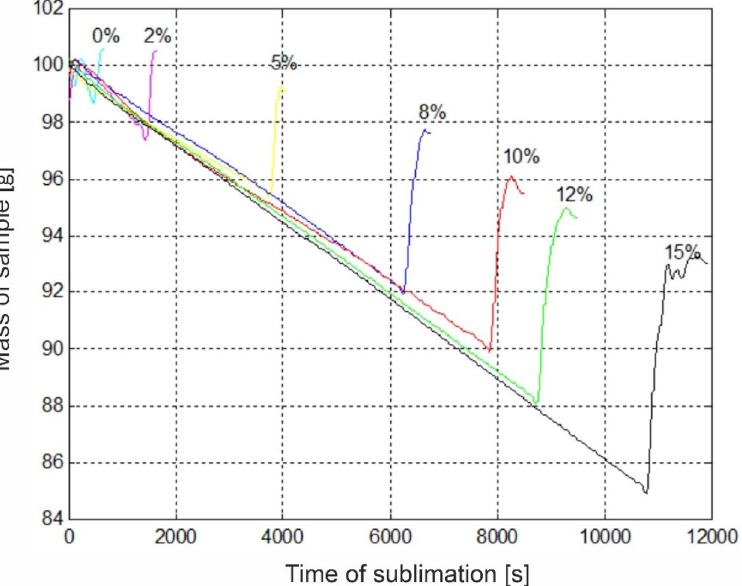
Figure 2. The mass of sample changes during sublimation for different degrees of sublimation dehydration S s